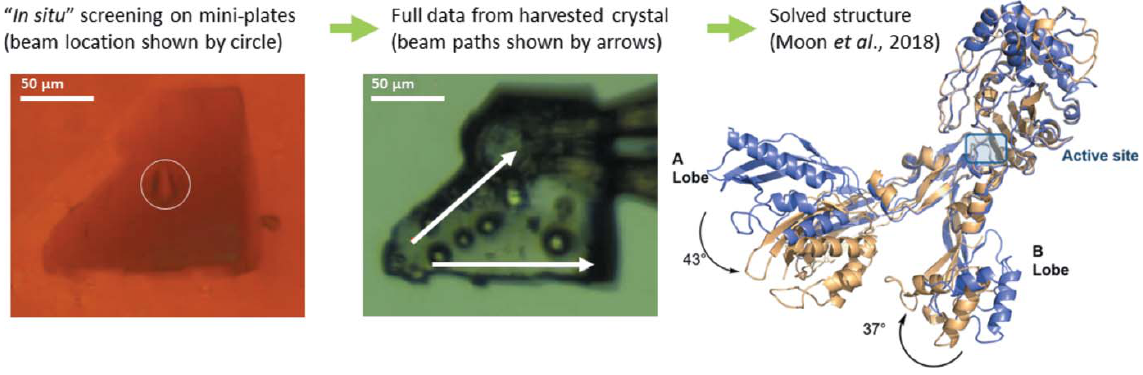
Figure 9 Workflow for in situ screening on mini-plates followed by full data collection on a harvested crystal. A single crystal was obtained from acoustically prepared nanolitre crystallization screens. The crystal was screened in situ at room temperature (left), then full vector data were obtained at 100 K after harvesting (middle), and the data were used to solve the structure (right, purple structure; see Moon et al. ,